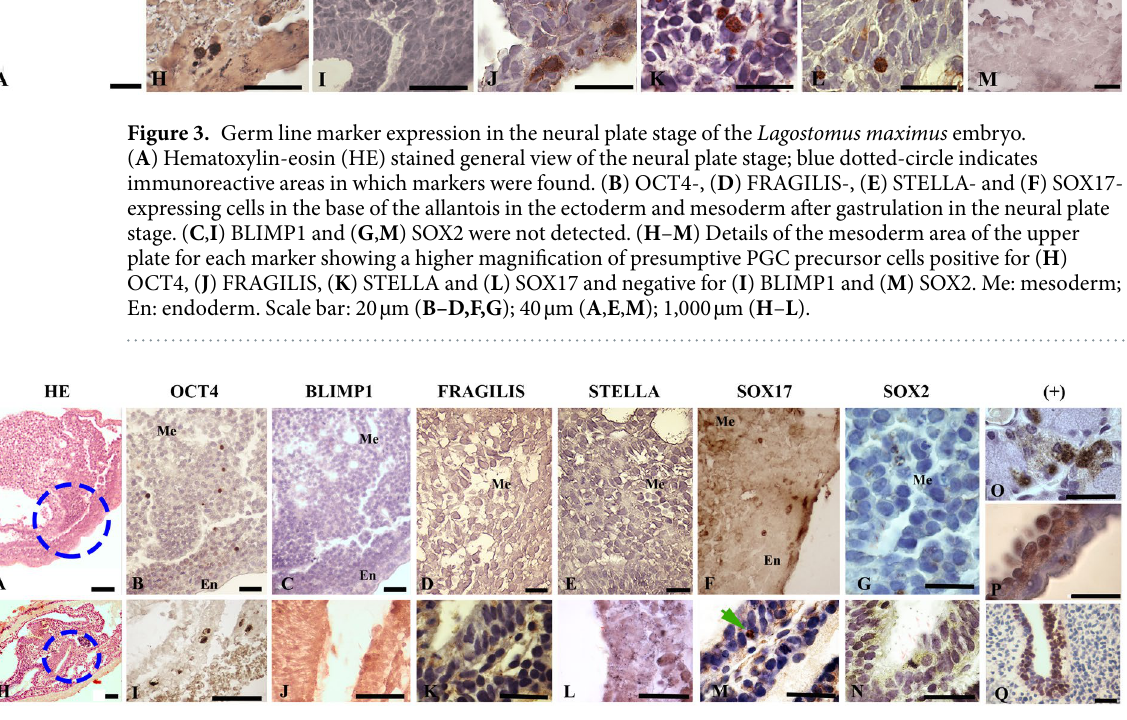
Figure 4. Localization of germ line marker-expressing cells in the early- and late-head fold stages in Lagostomus maximus embryos. Hematoxylin-eosin stained (HE) general views of ( A ) early- and ( H ) late-head fold stages showing areas in which the indicated markers were detected in the upper and lower plates, respectively (blue dotted circles). ( B ) OCT4-positive, ( C ) BLIMP1-negative, ( D ) FRAGILIS-negative, ( E ) STELLA-negative, ( F ) SOX17-positive and ( G ) SOX2-negative cells in the early-head fold embryo. ( I ) OCT4-positive, ( J ) BLIMP- negative, ( K ) FRAGILIS-negative, ( L ) STELLA-negative, ( M ) SOX17-positive (green arrows) and ( N ) SOX2- negative migratory PGCs in the endoderm in the late-head fold pre-somite embryo. Positive control ( + ): ( O ) BLIMP1 expression in tonsil tissue, ( P ) SOX17 expression in the visceral endoderm and ( Q ) SOX2 expression in neural tube tissue, all from L. maximus . Me: mesoderm; En: endoderm. Scale bar: 20 µ m ( H ); 40 µ m ( A – F , I , Q ); 1,000 µ m ( G , J – N , O , P